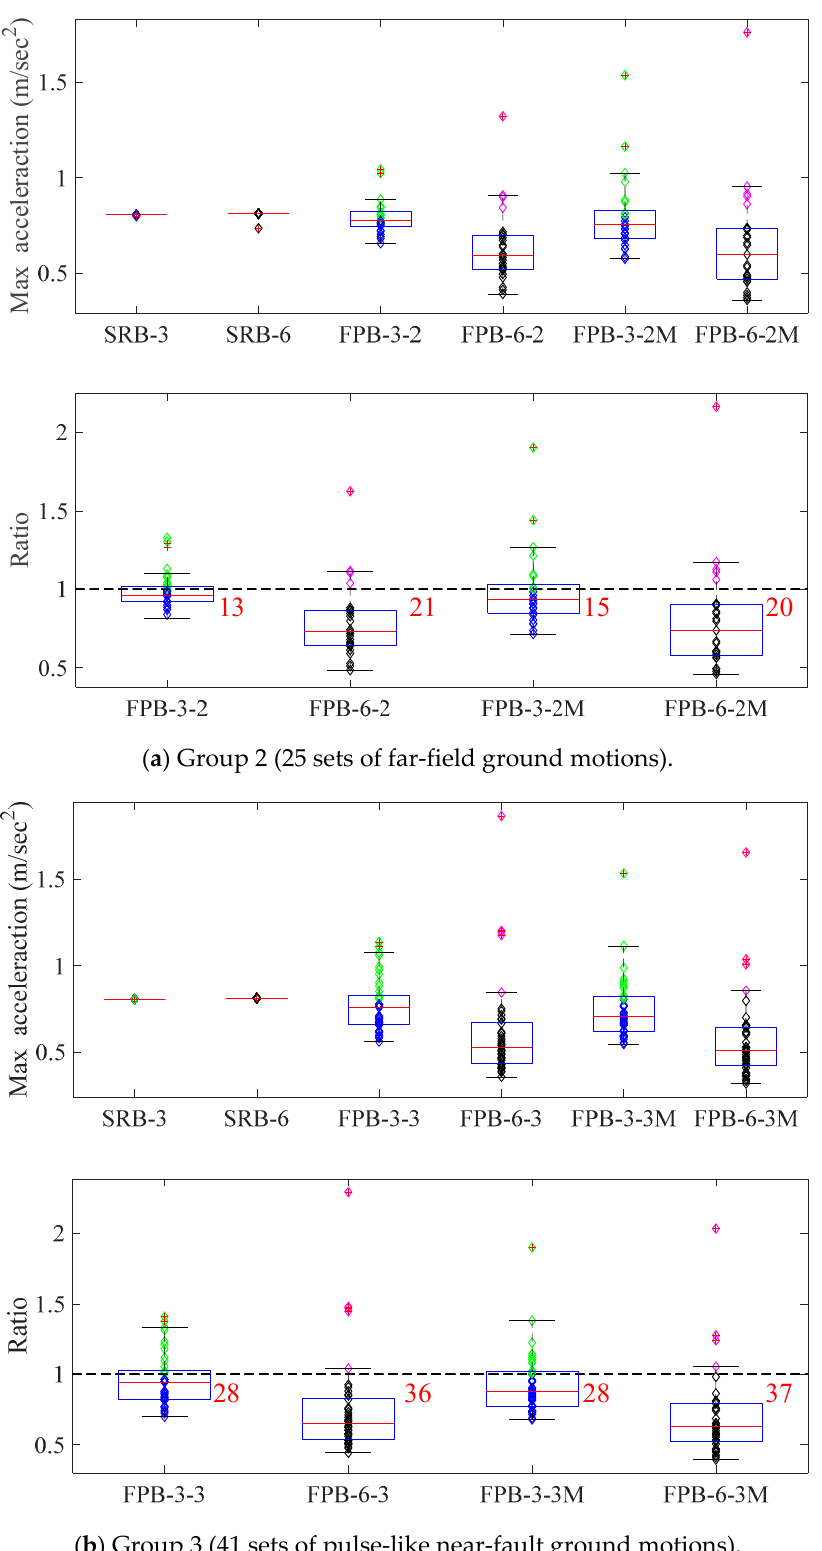
Figure 12. Comparisons of maximum horizontal acceleration responses of SRBs and FPBs subjected to different ground motions.